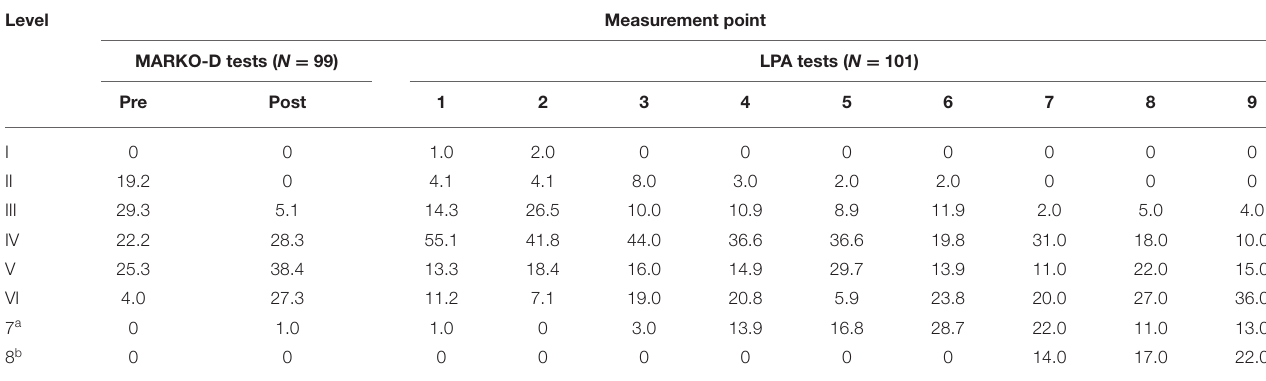
TABLE 7 | Level-based analysis of MARKO-D tests and LPA tests (relative frequencies in %).